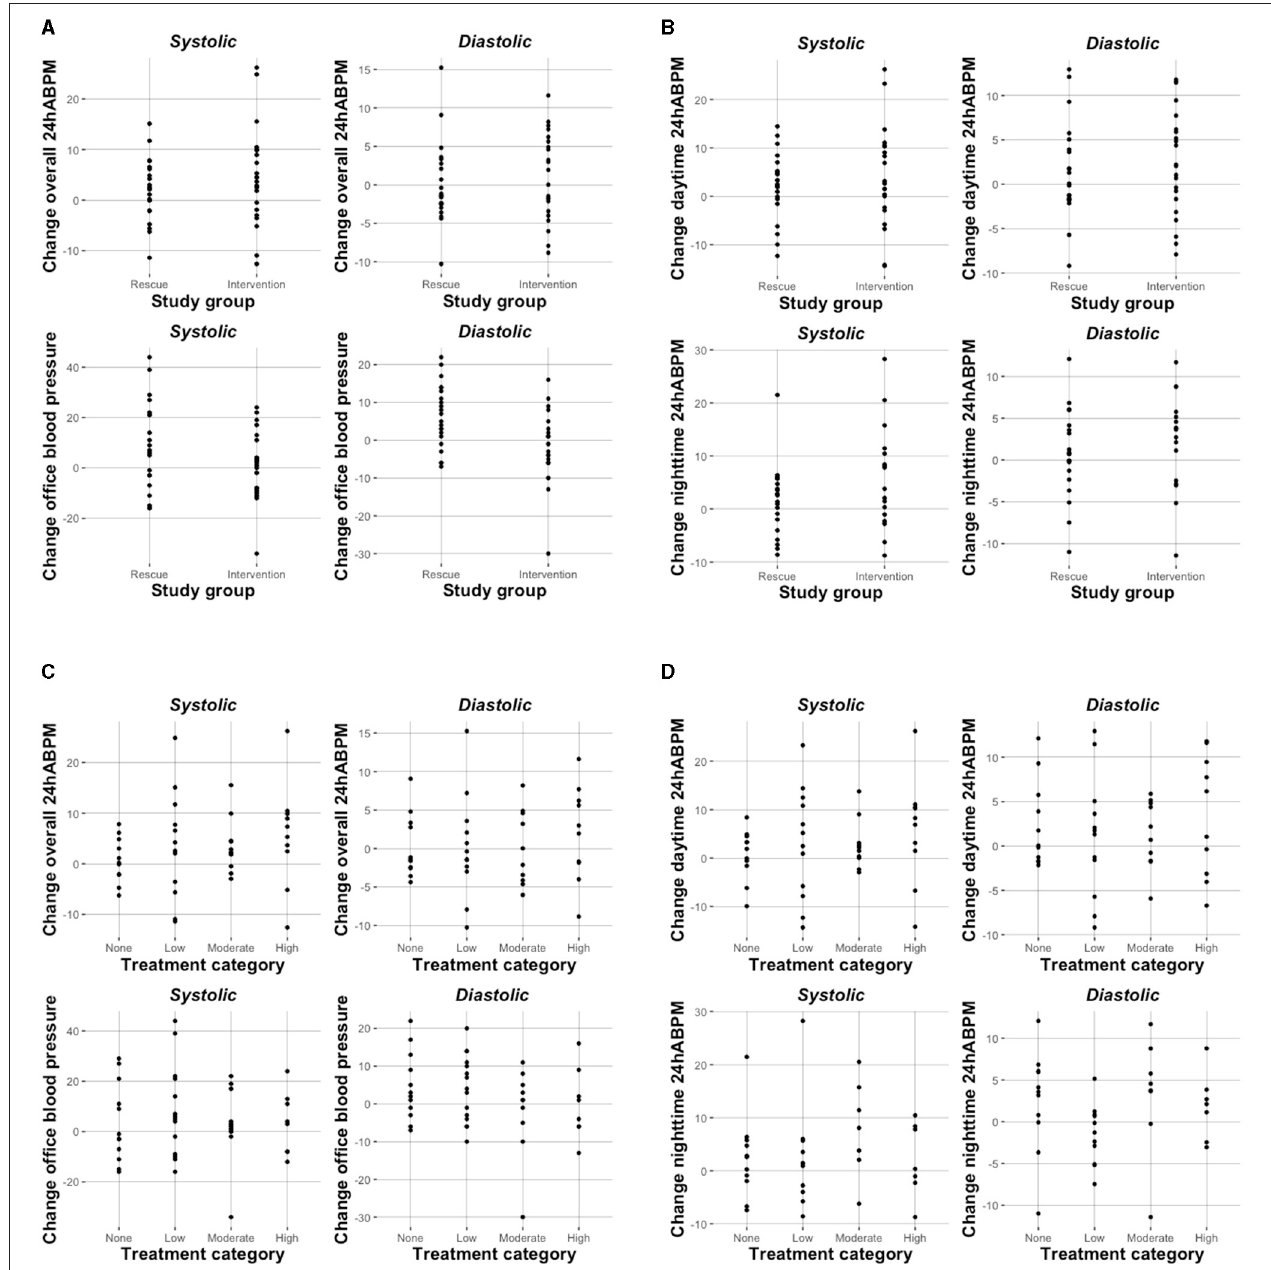
FIGURE 2 | Change in blood pressure (mmHg) with respect to study group (A,B) and treatment category (C,D)